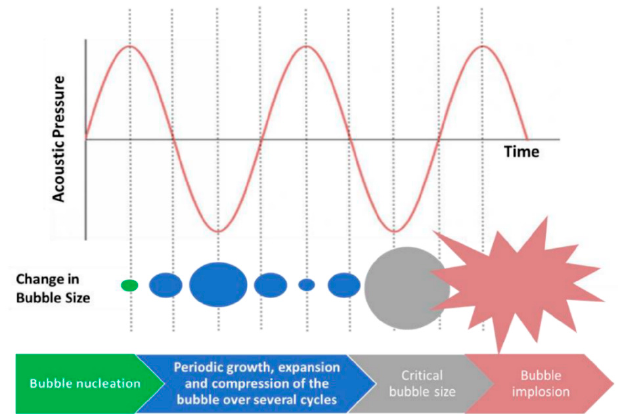
Figure 6. Schematic representation of three-fold acoustic cavitation phenomenon. Reproduced with permission from Reference [67]. Open Access 2020, MDPI Energies.